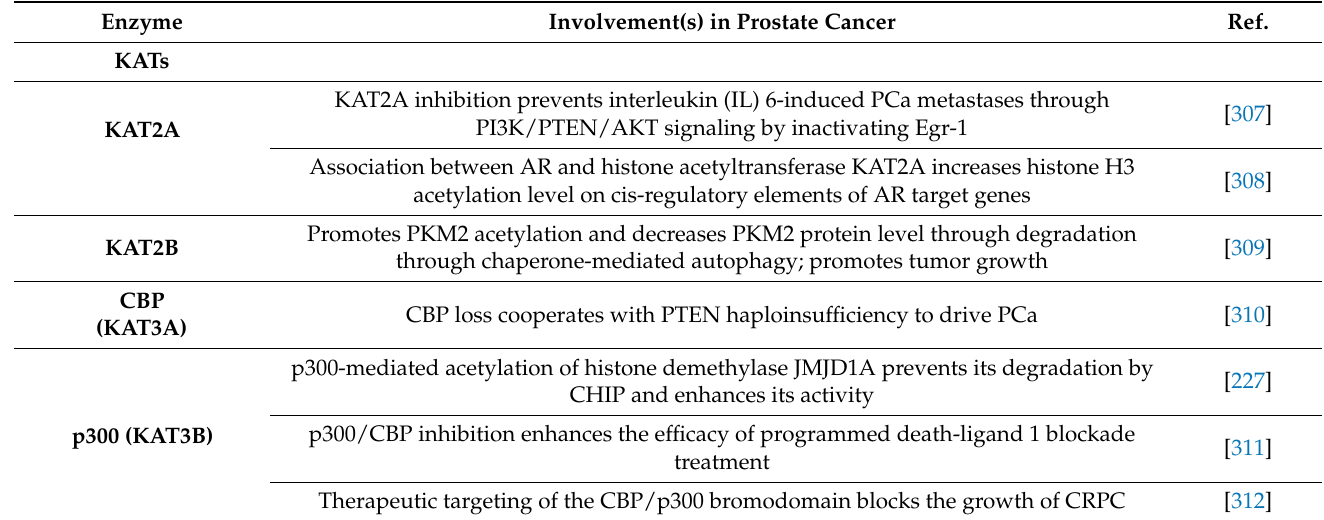
Table 4. Roles of (de-)acetylating enzymes in prostate cancer.